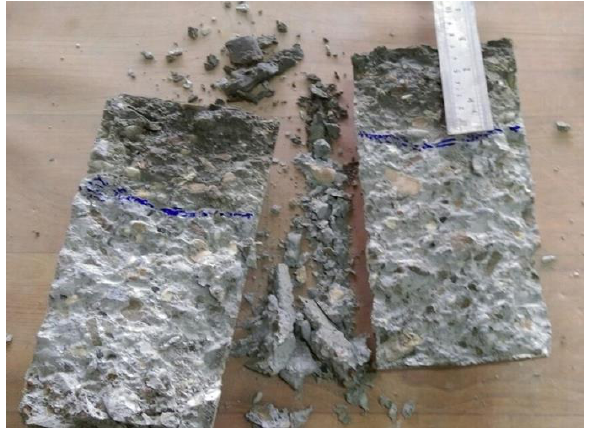
Figure 5. Measuring water penetration in the cylindrical sample.